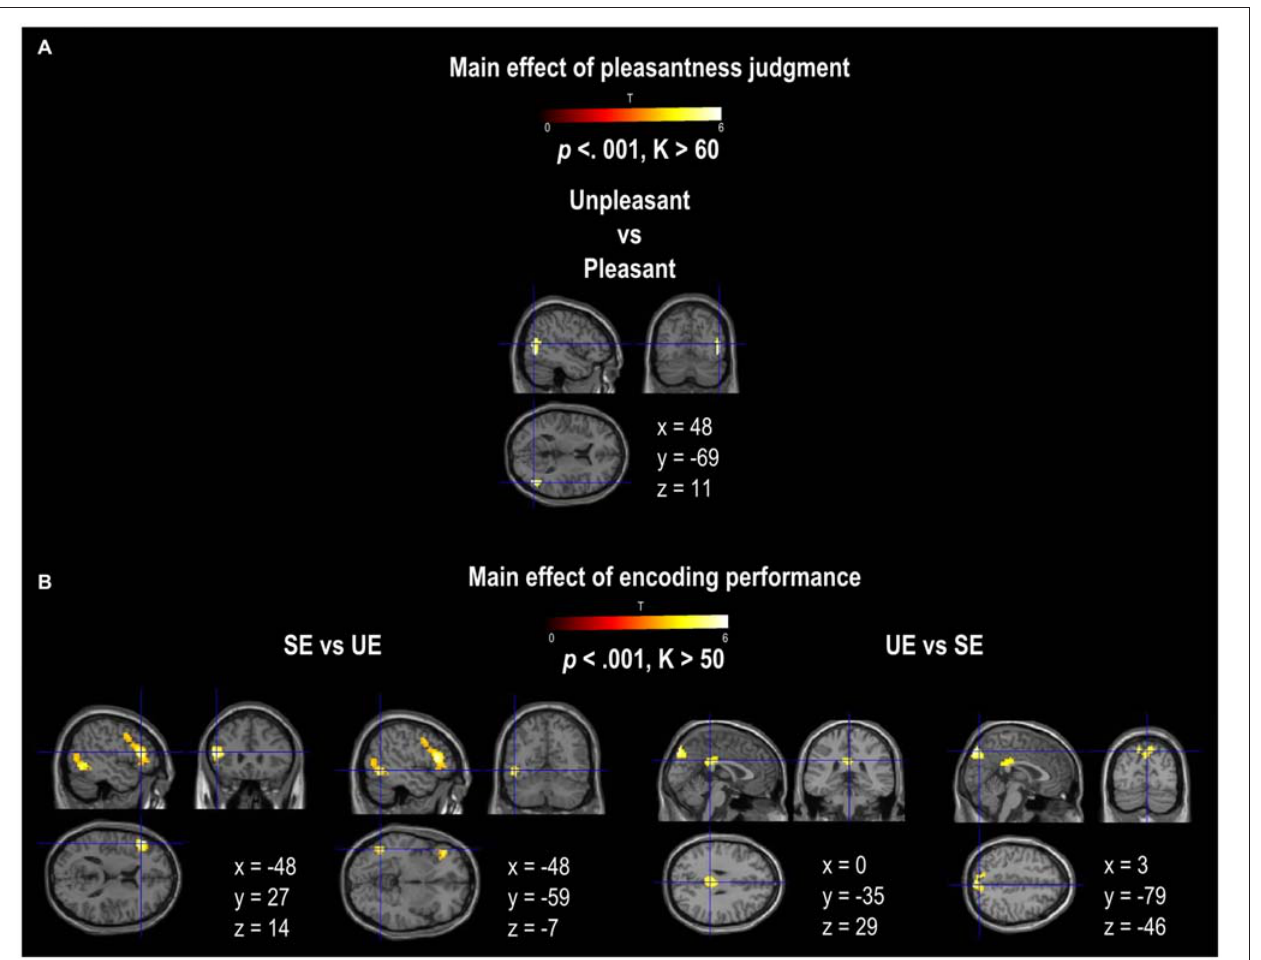
FIGURE 3 | Activation provided by the random-effect group analyses. (A) shows the activation for the main effect of pleasantness judgment (Pleasant vs. Unpleasant; Unpleasant vs. Pleasant). (B) shows the activation for the main effect of encoding performance (SE vs. UE and UE vs. SE). The activation is projected onto 2D anatomical slices in axial, coronal, and sagittal orientations, MNI coordinates are presented. The color scale indicates the T value of the activation (height threshold T = 3.55, p < 0.001 uncorrected) with a voxel cluster extent estimated for each contrast with a Monte Carlo simulation. Abbreviations: SE, Successful Encoding; UE, Unsuccessful Encoding.